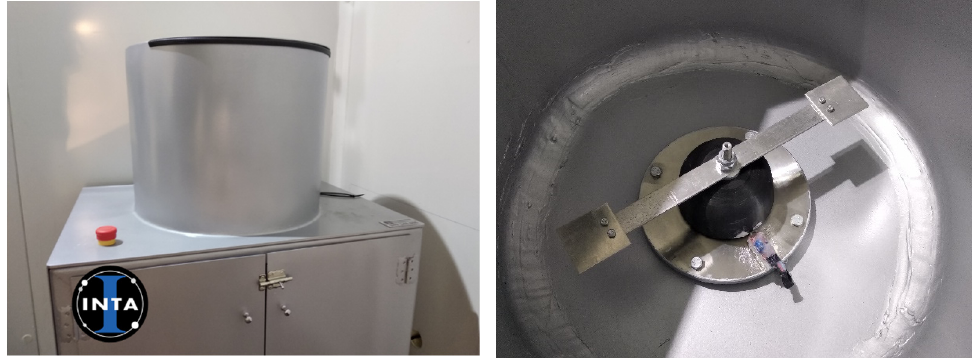
Figure 4. Centrifuge adhesion test (CAT) on a rotatory beam.